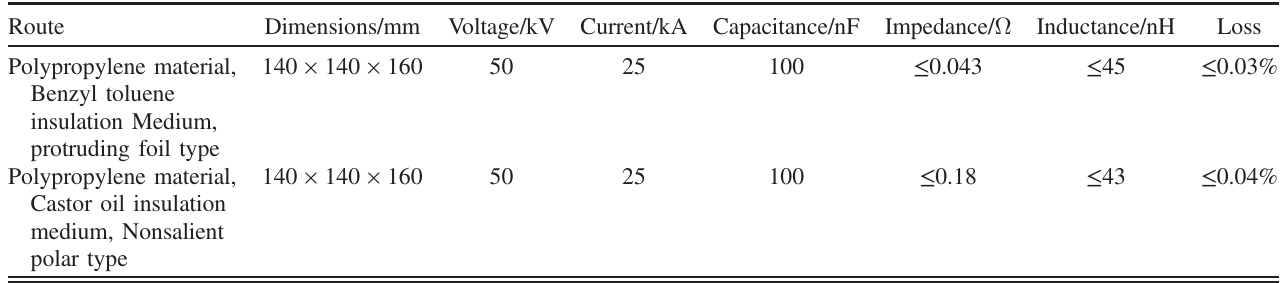
TABLE III. Comparison of parameters of the high voltage pulse capacitors with two optimal designs. Route